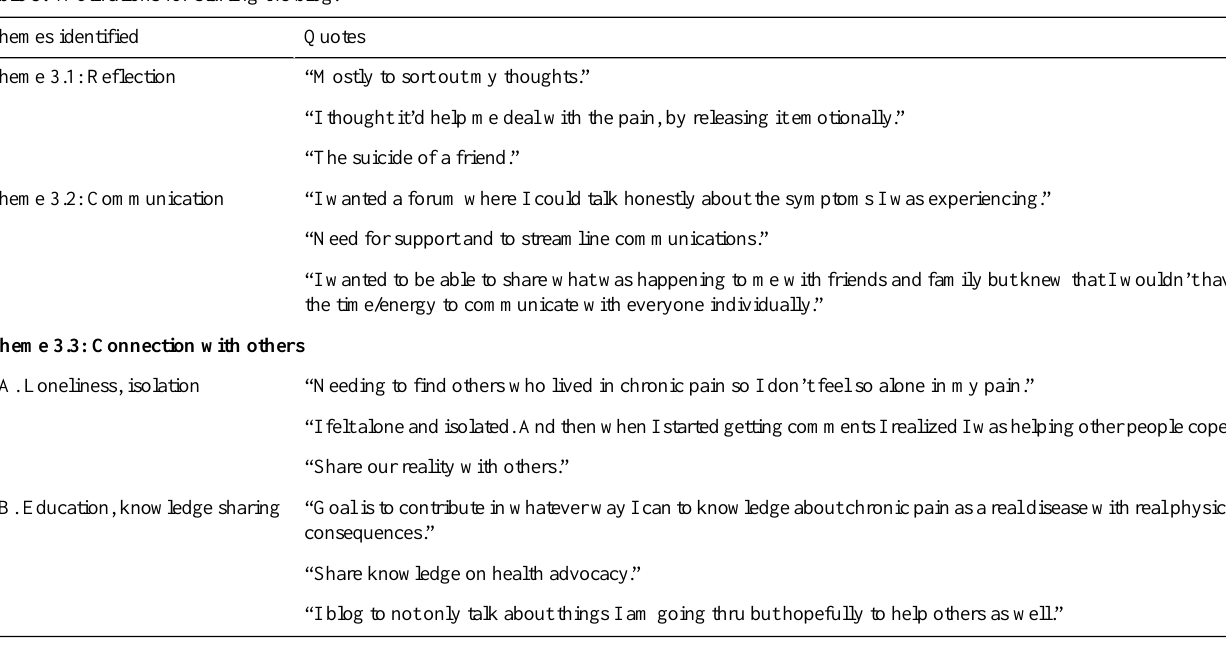
Table 5. Motivations for starting the